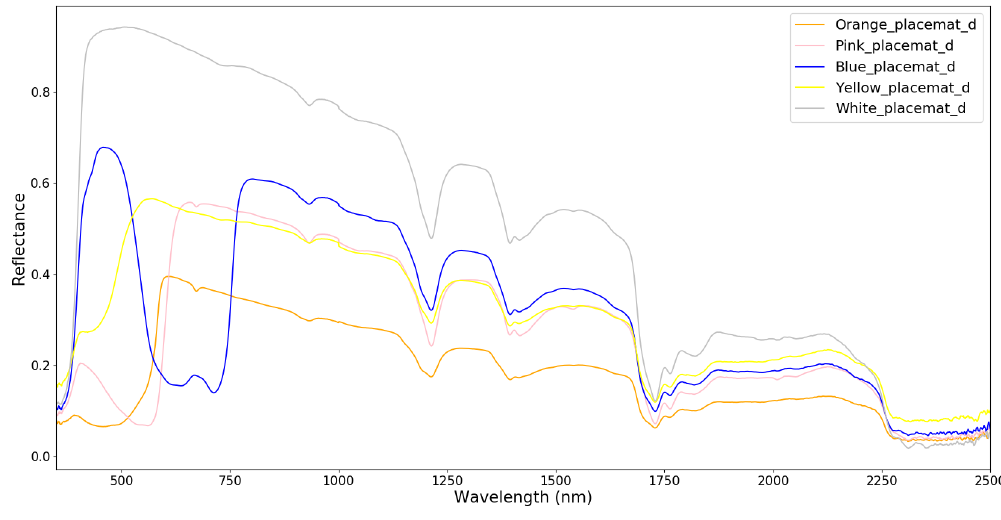
Figure 4. Spectral reflectance of dry plastic place mats.